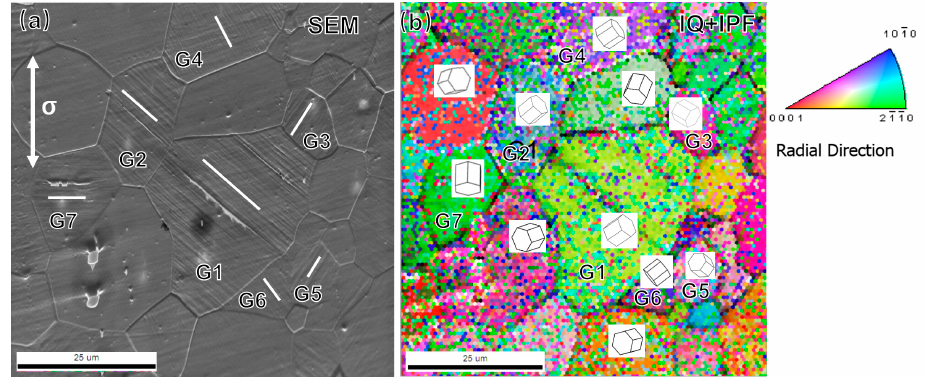
Figure 3. Cyclic deformation mechanisms at a stress amplitude of 130 MPa. ( a ) Slip bands at specimen surface; ( b ) Combined mode of image quality (IQ) and inverse pole figure (IPF) in ( a ).